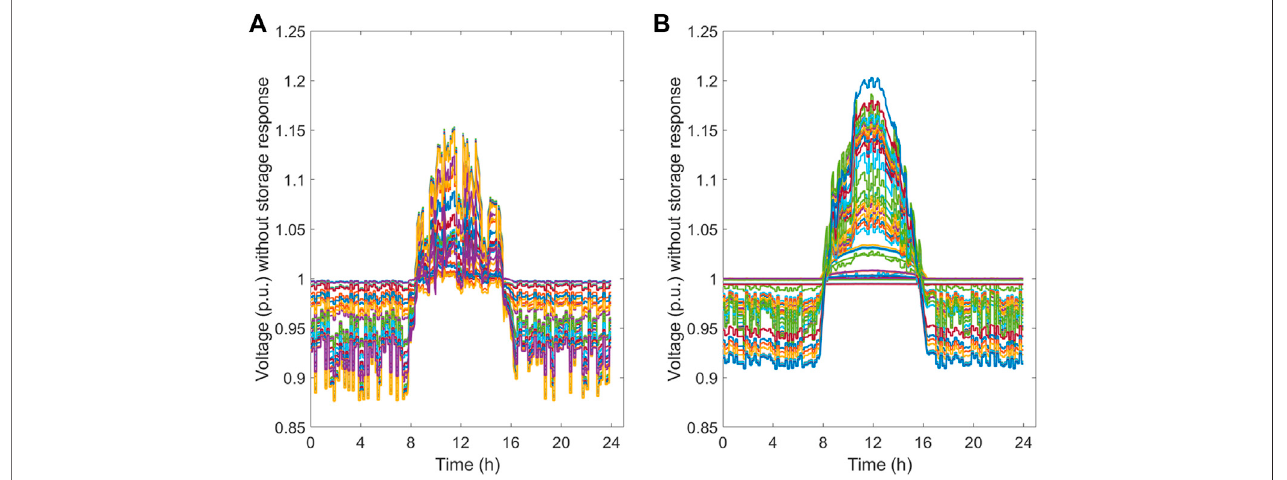
FIGURE 3 | System voltage pro fi les under no storage response: (A) IEEE 33-bus system and (B) IEEE 69-bus system.